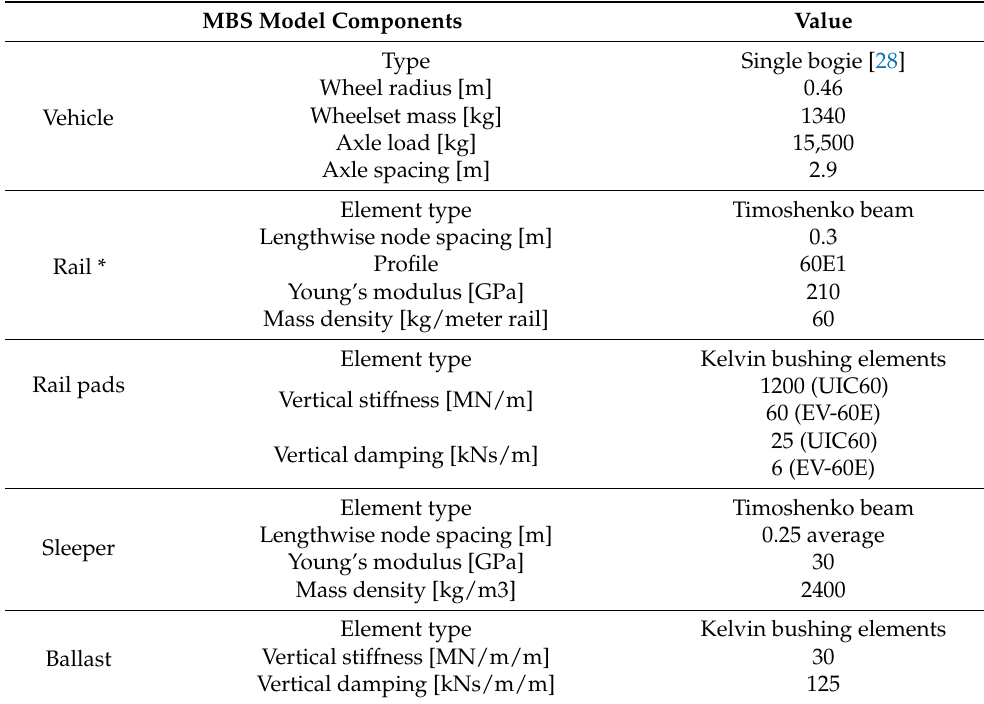
Figure 9. Wheel profile set used in the MBS analysis. Nominal wheel profile S1002 is marked with black color and the scanned Regina passenger train wheel profiles are marked with continuous colored lines, while the three hollow-worn wheel profiles are marked with dashed lines. Table 4. Nominal MBS parameter values with vehicle parameters that correspond to an X2 train cabin car bogie.